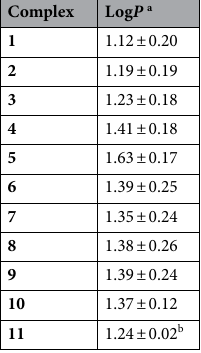
Table 2. Experimentally-determined log P values for complexes 1 – 11 at pH 7.4 a Mean ± SEM (N = 3). b Taken from Ref. 8 .